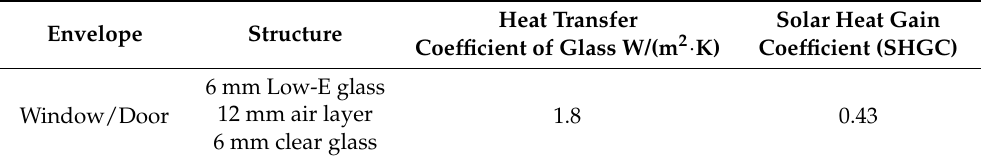
Table 2. Thermophysical parameters of transparent envelope.